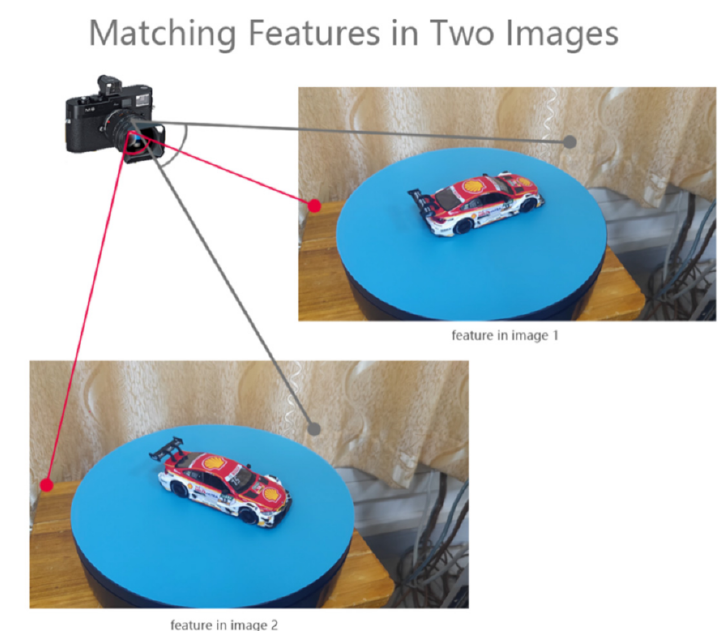
Figure 8. The angle of the ray at the triangulation point.